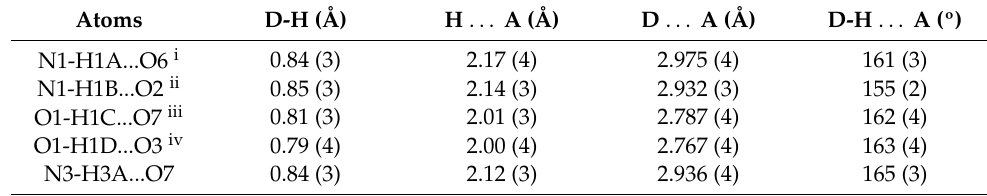
Figure 4. The hydrogen bond contacts ( left ) and packing along the ac plane ( right ). Table 2. The hydrogen bond parameters of complexes 1 and 2 .